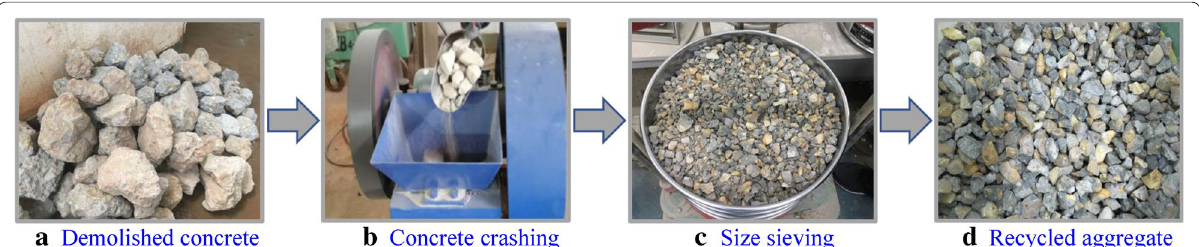
Fig. 1 Recycled coarse aggregate manufacturing.